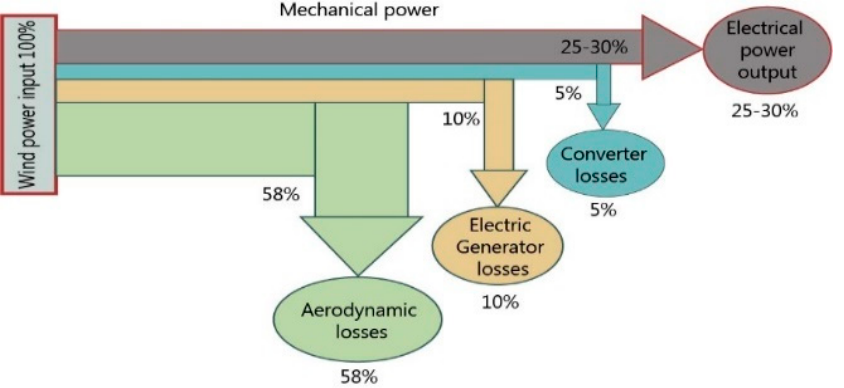
Figure 5. Power conversion stages in wind energy.